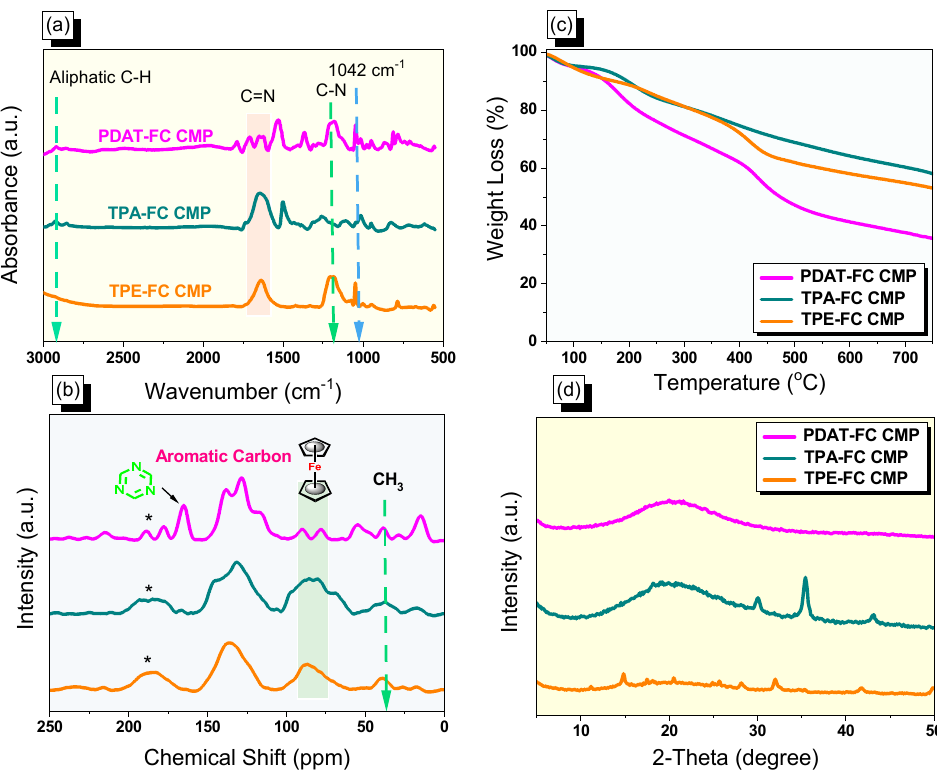
Figure 1. ( a ) FTIR, ( b ) 13 C NMR solid state, ( c ) TGA, and ( d ) XRD profiles PDAT-FC, TPA-FC, and TPE-FC CMPs. * is the side band of solid-state nuclear magnetic resonance spectroscopy (NMR).